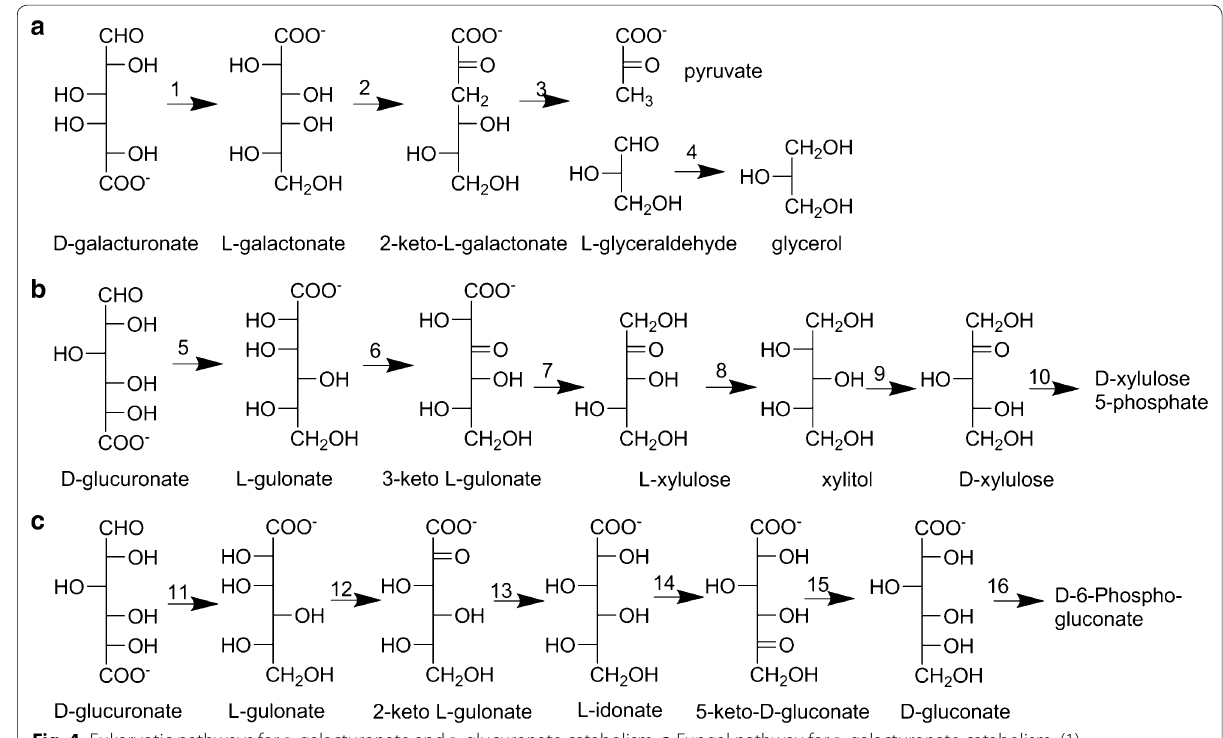
Fig. 4 Eukaryotic pathways for d -galacturonate and d -glucuronate catabolism. a Fungal pathway for d -galacturonate catabolism: (1) d -galacturonate reductase EC 1.1.1.365 (2) l -galactonate dehydratase EC 4.2.1.146 (3) 2-keto-3-deoxy-galactonate aldolase EC 4.1.2.54 (4) l -glyceraldehyde reductase EC 1.1.1.372. b Animal pathway for d -glucuronate catabolism: (5) d -glucuronate reductase EC 1.1.1.19 (6) l -gulonate 3-dehydrogenase EC 1.1.1.45 (7) 3-dehydro- l -gulonate decarboxylase EC 4.1.1.34 (8) l -xylulose reductase EC 1.1.1.10 (9) Xylitol dehydrogenase EC 1.1.1.21 (10) xylulokinase EC 2.7.1.17. c Fungal pathway for d -glucuronate catabolism: (11) d -glucuronate reductase EC 1.1.1.19 (12) hypothetical reaction (13) 2-keto- l -gulonate reductase (14) l -idonate-5-dehydrogenase EC 1.1.1.264, EC 1.1.1.366 (15) 5-keto-gluconate reductase EC 1.1.1.69 (16) gluconokinase EC